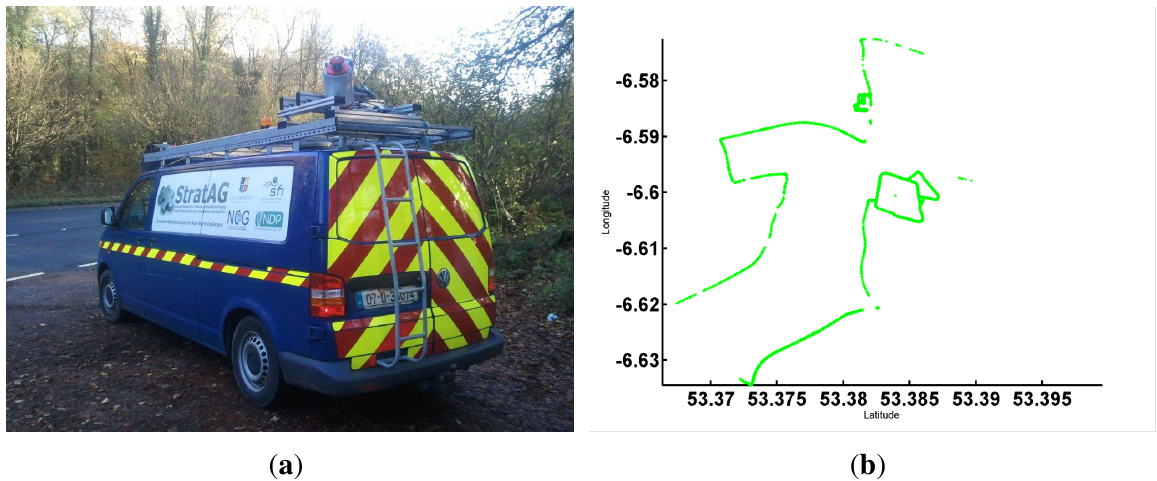
Figure 2. Mobile Mapping Systems and GNSS Quality ( a ) the XP1 MMS, designed and developed at the NCG ( b ) a 2D plot of GNSS satellite signal exhibiting signal loss due to obstructions during an MMS